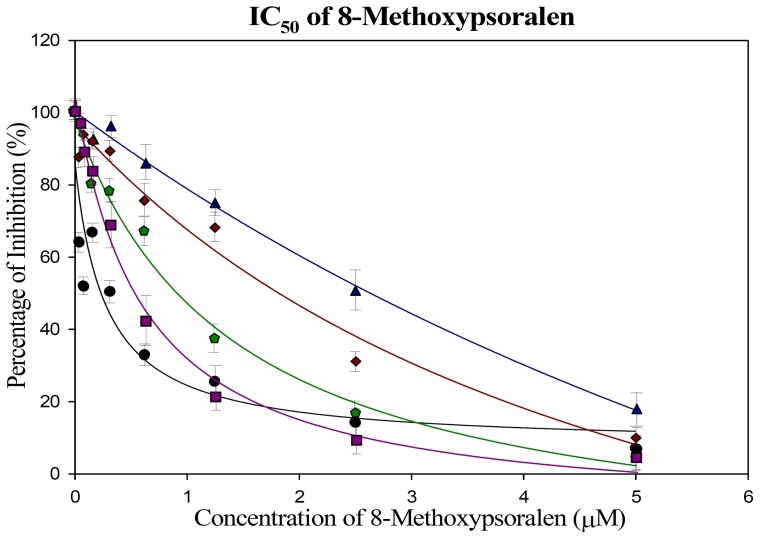
Representative IC50 plots demonstrating the inhibitory effect of 8-methoxypsoralen at concentration of 0–5 µM on CYP2A6*1 (wild type) (•), CYP2A6*15 (▴), CYP2A6*16 (▪), CYP2A6*21 (♦) and CYP2A6*22 .
Points are experimentally determined values while solid lines are the computer-generated curves of best fit (by SigmaPlot® programme). Data are presented as mean values from triplicate measurements.